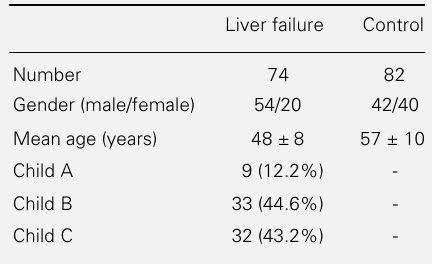
Table 1 - Characteristics of the